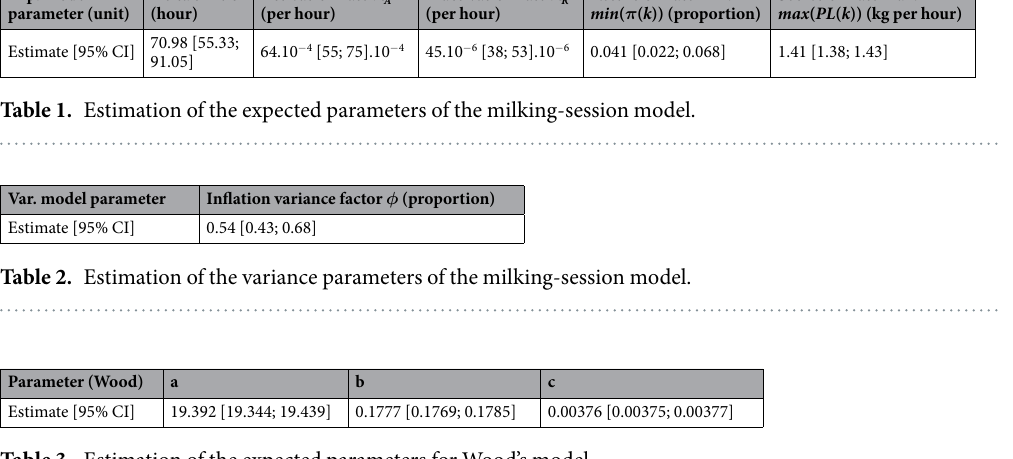
Table 3. Estimation of the expected parameters for Wood’s